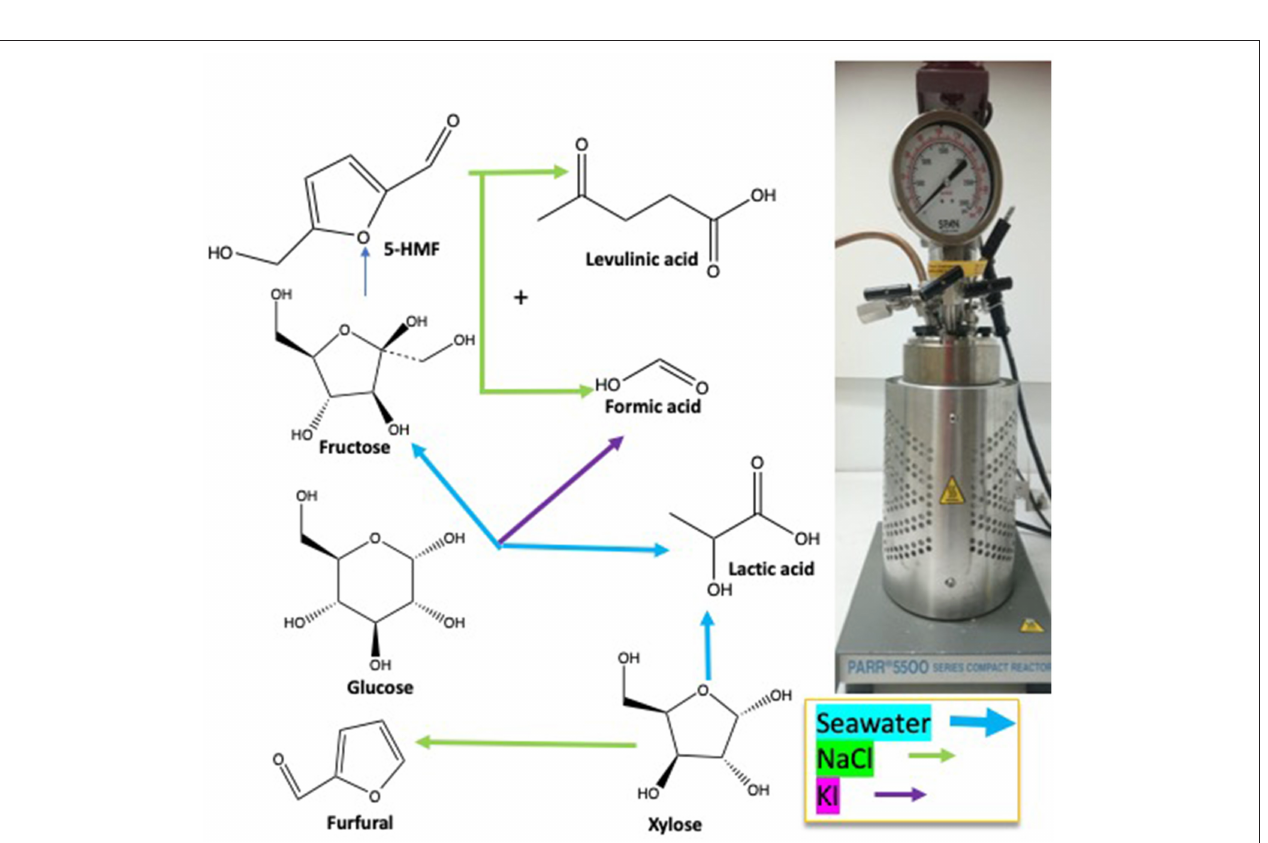
FIGURE 10 | Seawater is a cheap, abundant and safe medium able to improve conversion and dehydration reactions of monosaccharides compared to salts aqueous medium.